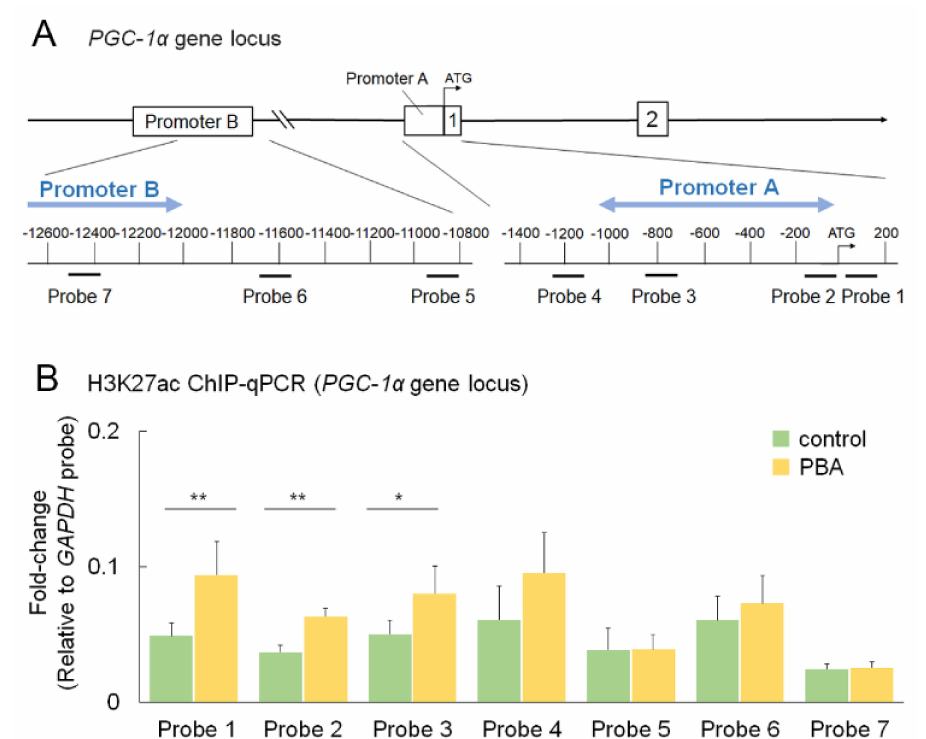
Figure 6. Histone acetylation of PGC-1 α promoter by PBA ( A ) Schematic illustration of upstream of human PGC-1 α gene including promoters A and B. ( B ) ChIP-qPCR showed that amplified DNA levels were significantly increased with probes 1, 2, and 3, which are involved in promoter A. Data are shown as mean ± standard deviation. Respective n for control and PBA; 5 and 6. * p < 0.05, ** p <